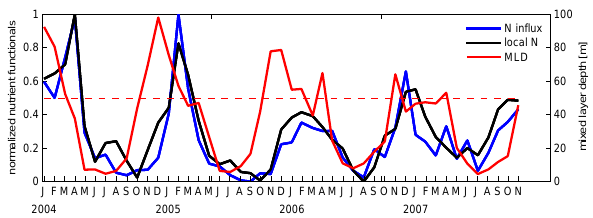
Figure 10. Monthly means of domain-averaged upper 50m nutrient concentration (black line), the upstream nutrient influx (blue line), and the surface mixed layer depth (red line) from 2004 to 2007. Also shown in the dashed red line is 50 m as a reference depth for MLD. Both N-influx and local N time series are normalized, whereas the domain- averaged, monthly mean MLD is not and has unit of meter.